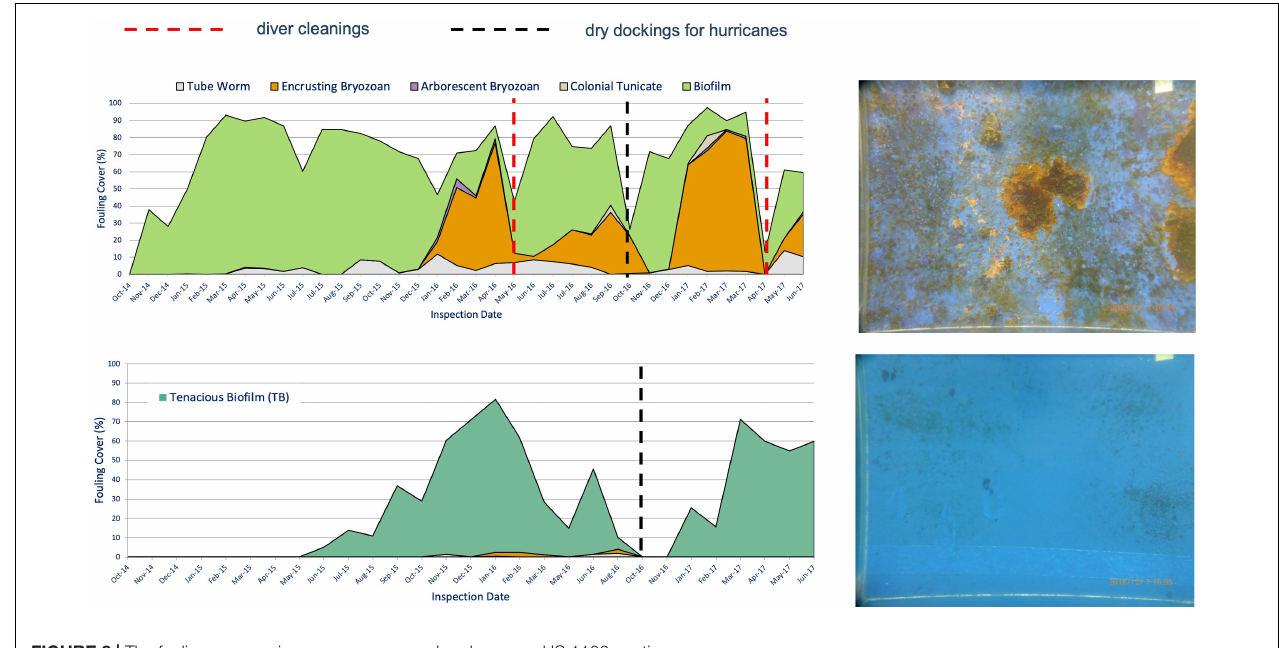
FIGURE 8 | The fouling progression on an ungroomed and groomed IS 1100 coating.